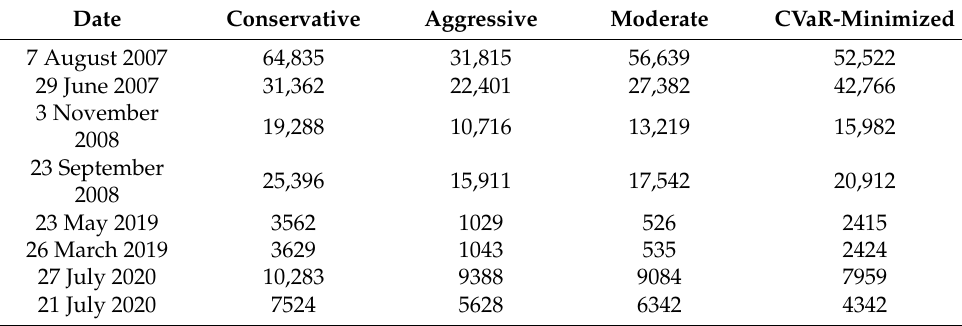
Table 4. Amount of loss stopped by JERP (unit: